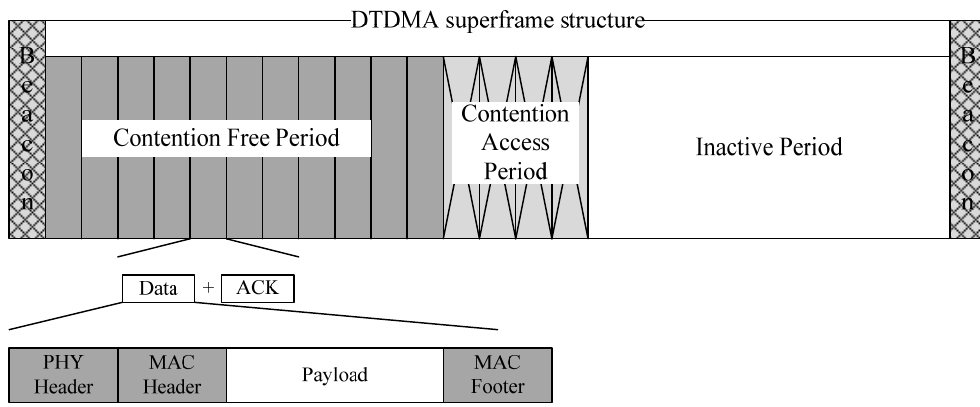
Figure 3. DTDMA superframe